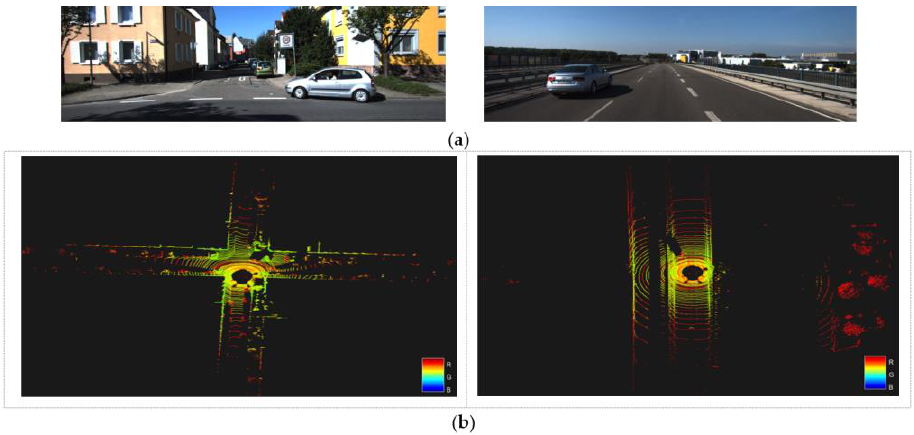
Figure 3. Acquired data by a vehicle at a moment of motion. ( a ) The FOV images; ( b ) The lidar 3D point